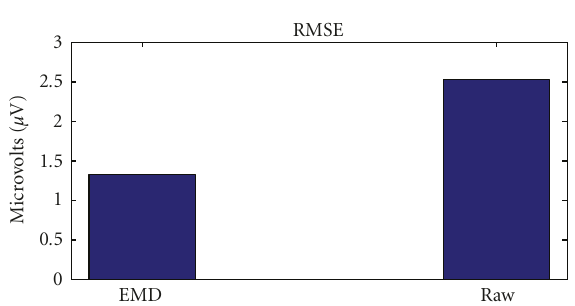
Table 2: Denoising performance of EMD.